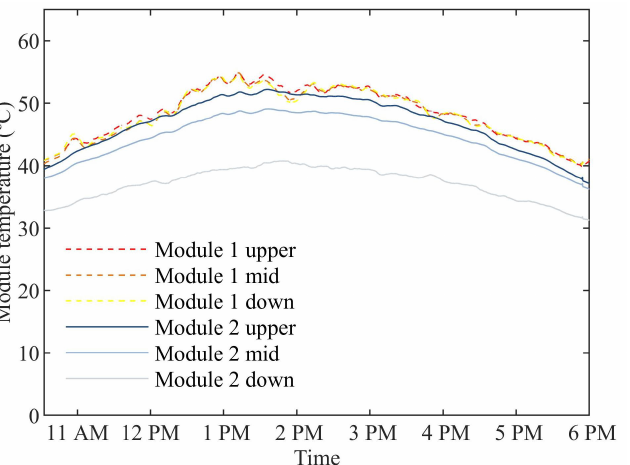
Figure 2. Temperature distributions in the PV modules. Adapted from Lucas et al.